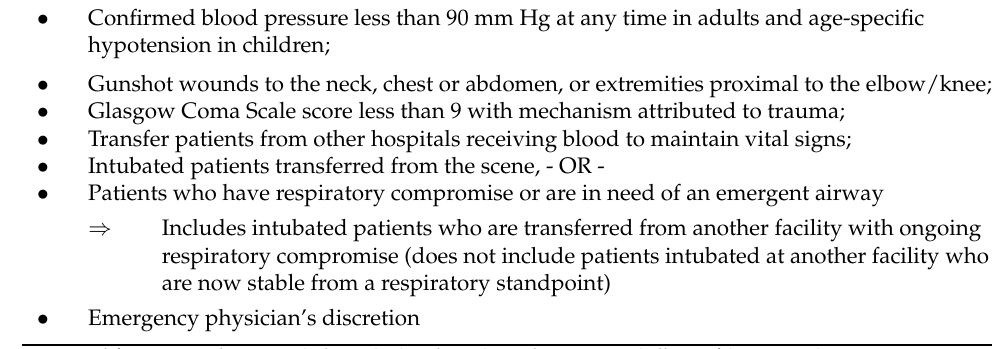
Table 2. Minimum Criteria for Full Trauma Team